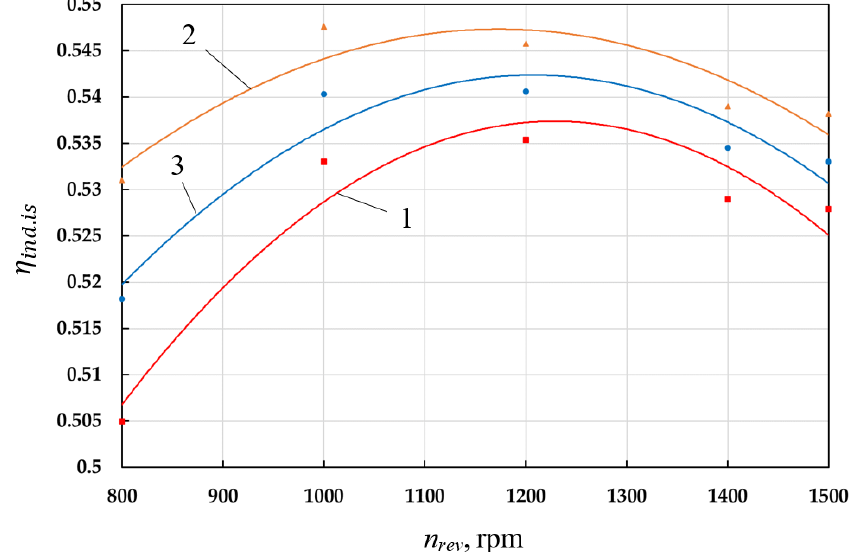
Figure 13. Dependence of the indicator isothermal efficiency of the left (1 — 𝜂 𝑖𝑛𝑑.𝑖𝑠1 ) and right (2 — 𝜂 𝑖𝑛𝑑.𝑖𝑠2 ) cylinders and the average value (3 — 𝜂 𝑖𝑛𝑑.𝑖𝑠.𝑎𝑣 ) on the crankshaft speed.